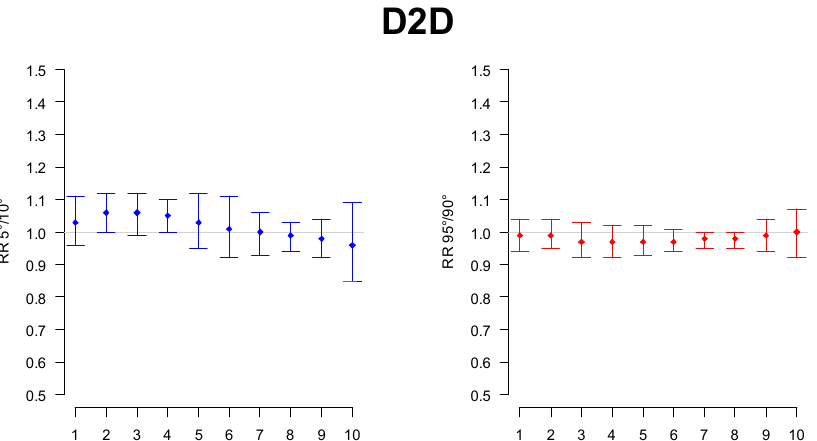
Figure 1. Relative risk of hospital admission in the lowest (“RR5vs10”, in blue) and highest tail of the variable distribution (“RR95vs90”, in red) for the temperature difference with respect to the previous day (D2D).